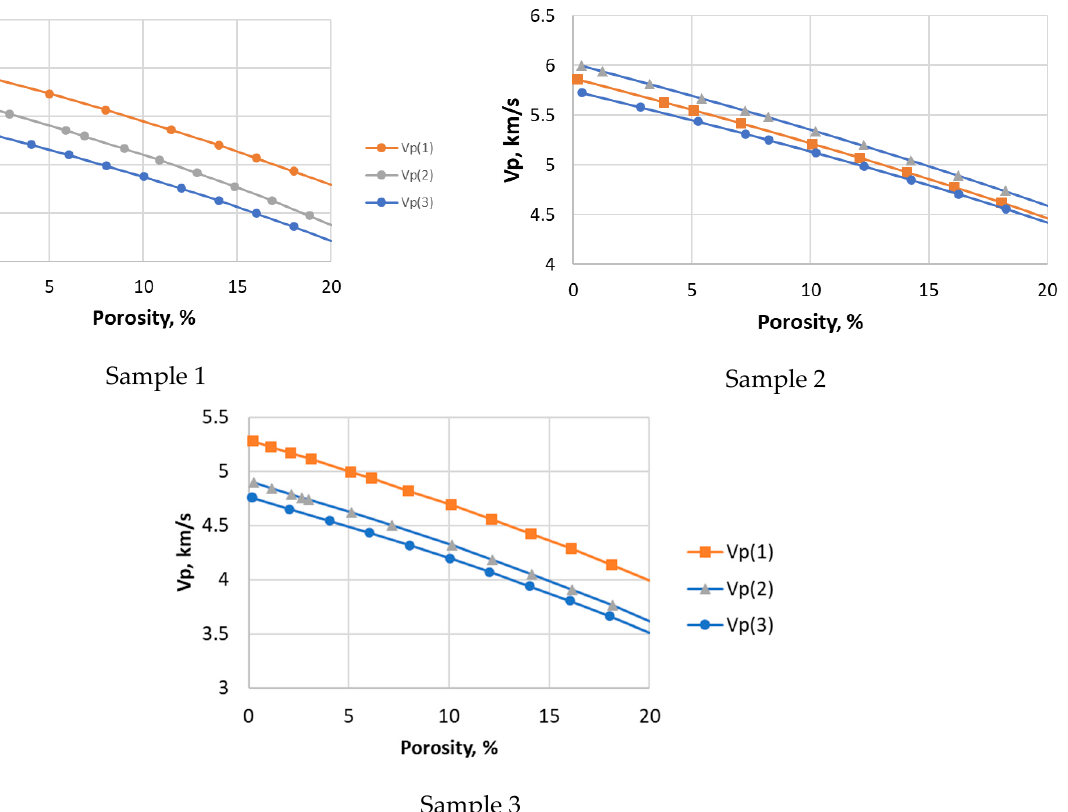
Figure 16. Prediction of P-wave velocities for fluid-saturated rocks. For fluid substitution, the Gassmann method was used. Microcrack parameters are constant and correspond to those found for each dataset. Notation (1), (2), (3) signifies the sets of data (Datasets 1–3) used to solve the inverse problem (see the description of the datasets in Section 3.2). Quasi-isometric porosity varies from 0.1 to 20%. The symbols on the curves correspond to porosity values for which the velocities were cal- culated.